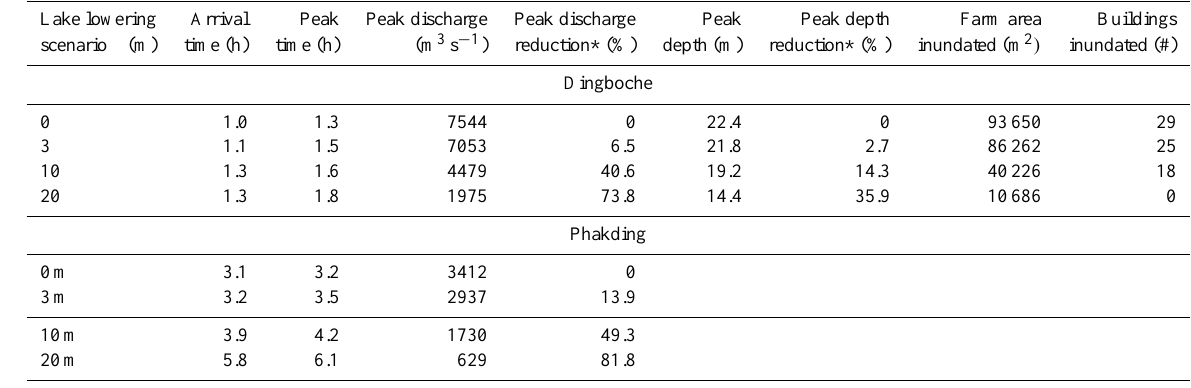
Table 5. Inundation model results at Dingboche and Phakding for lake lowering scenarios under current conditions. Lake lowering